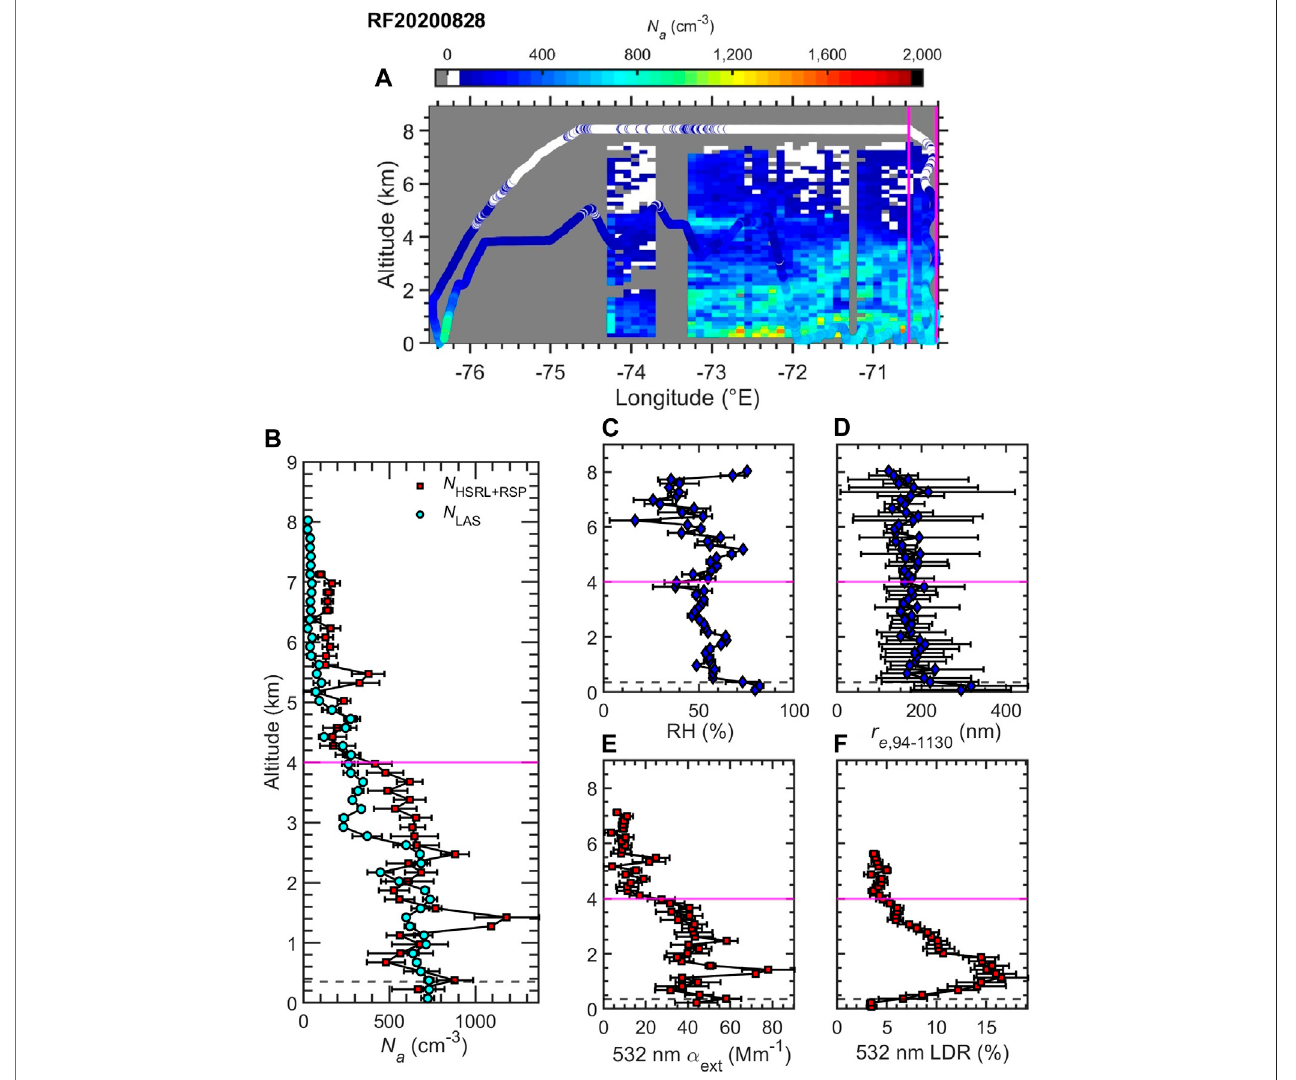
FIGURE 4 | Horizontal curtain (A) and vertical pro fi les (B – F) of remote sensing and in situ data gathered from the ‘ optimal ’ fl ight that occurred on 28 August 2020. The vertical pro fi les were taken from the in situ pro fi le that occurred between 17:35:18 and 17:54:11 (UTC) on 28 August 2020. Panel (A) shows the fl ight track and surface plot colored by N LAS and N HSRL+RSP , respectively, where the magenta vertical lines mark the start and stop locations of the fi rst optimal vertical in situ pro fi le. Panel (B) showverticalpro fi lesofaverageaerosolparticlenumberconcentration(derivedfromthevariousmethods), (C) RH, (D) r e ,94 – 1130 , (E) 532 nm α ext ,and (F) 532 nm LDR, where the whiskers mark ± one standard deviation. The horizontal dashed-black and solid-magenta lines mark the MLH and the ATH, respectively.